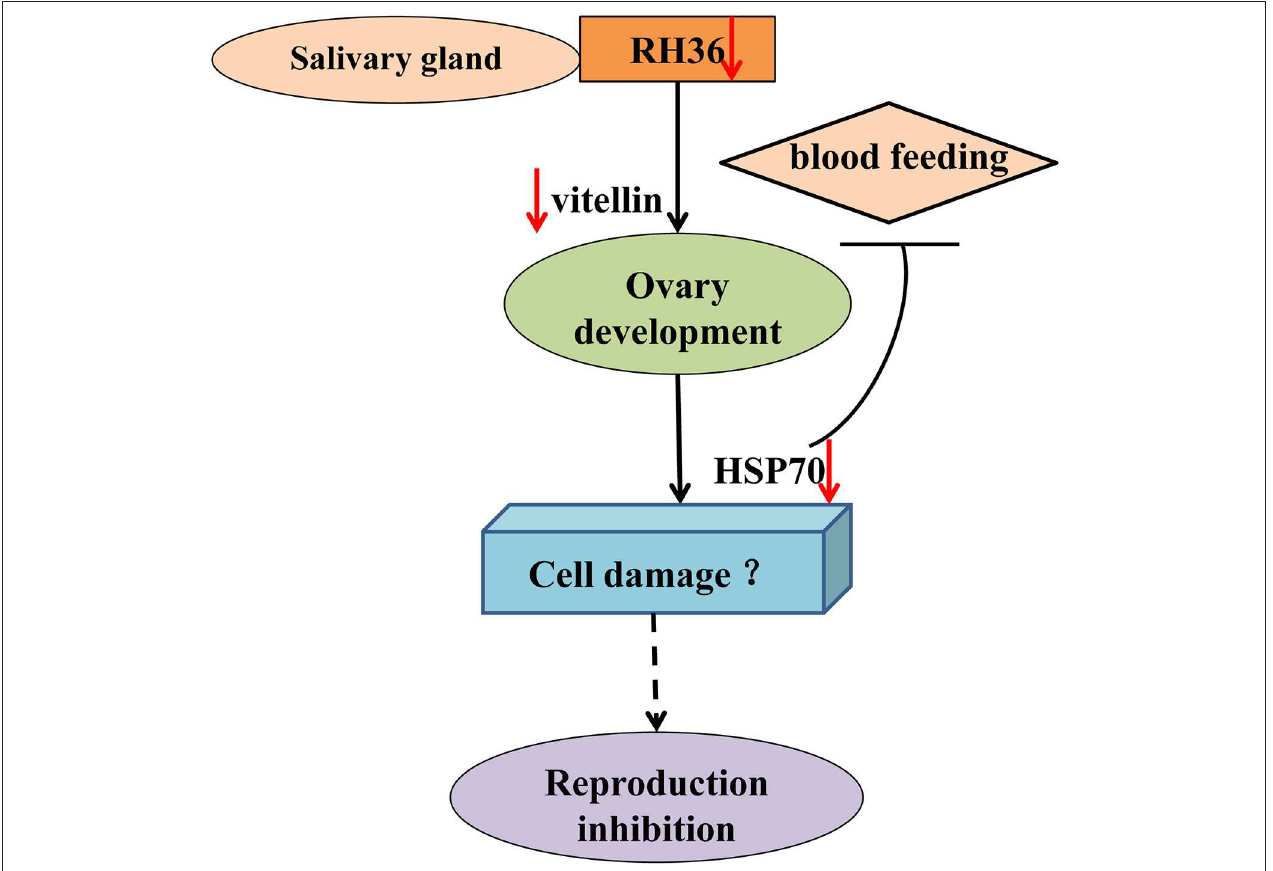
FIGURE 10 | Model of RH36 regulated tick oviposition via nutrition uptake. RH36 expressed-uniquely in salivary gland regulates tick blood feeding and ovary development by inhibiting vitellin uptake mediated by HSP70 protein using real-time quantitative PCR and Western blot. In addition, HSP70 gene silencing considerably increased tick death rate during blood feeding but it is still to be further studied that RH36 gene regulates tick oviposition by accelerating cell damage via HSP70.